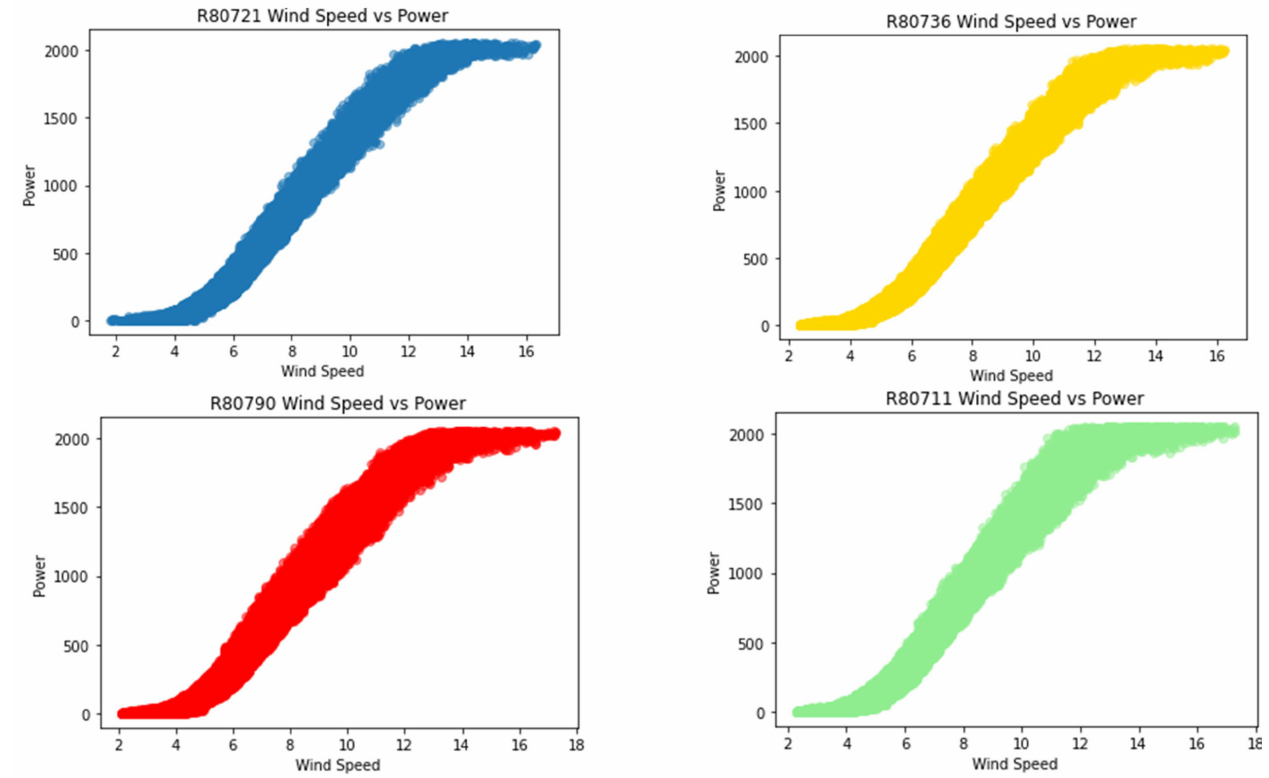
Figure 13. Power vs. Wind Speed Curve of Each